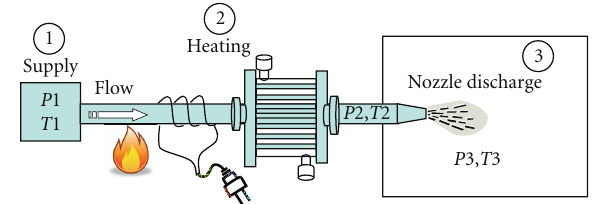
Figure 7: Illustration of flow process to create e ff ervescent atomiza- tion by boiling at the point of injection [18].